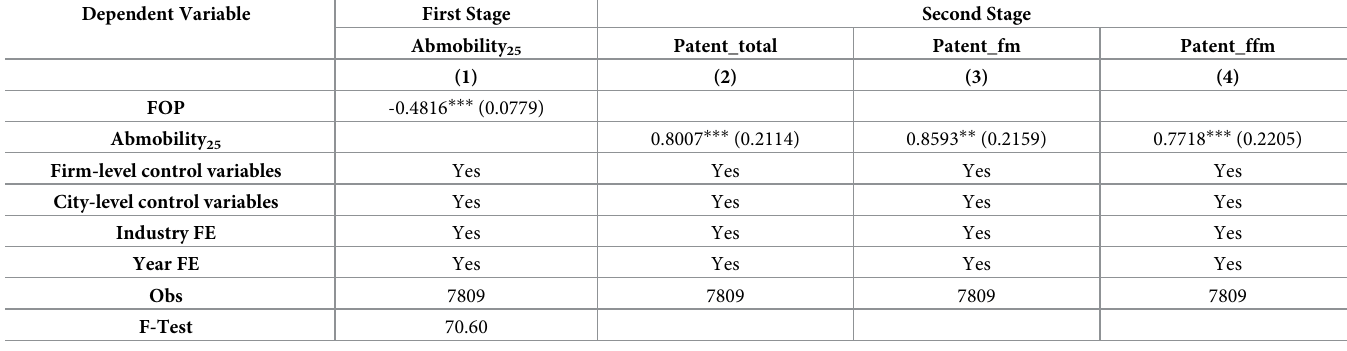
Table 7. Instrumental variable